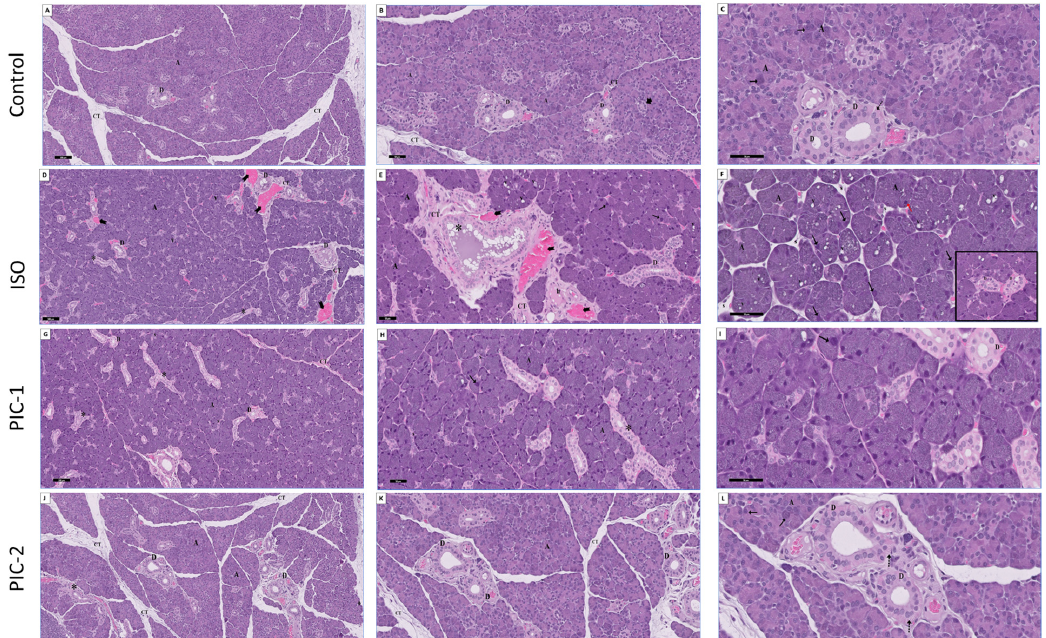
Figure 2. A section in the parotid gland stained with HE from the control group ( A – C ) showing the lobules of the gland, each lobule is formed of serous acini (A) and ducts (D) with wide connective tissue septa filled with a fine network of interlobular connective tissue fibers (CT) serous acini (A) consists of a single layer of pyramidal cells ( ↑ ) with basal rounded nuclei surrounding a lumen. Among the acini, intercalated ducts lined by cuboidal cells with rounded nuclei (arrowhead) and striated ducts (D) are observed and lined by a single layer of columnar epithelium (dot arrow) (HE; A × 100, B × 200, C × 400). ISO group ( D – F ) showing markedly hypertrophic packed secretory serous acini (A). Some of the acini exhibited irregular outline and spaces (s) appear between acini. The cytoplasm and basal lines of acinar cells are blurred, and the vacuolization (V) of acinar cells is obvious. Nuclei of serous acini appear enlarged and irregular in shapes and size with clumped chromatin hyperchromatic ( ↑ ) or with pyknotic nuclei (red ↑ ). Striated duct (D) appears disorderly arranged epithelium lining with loss of basal striation. Execratory ducts (*) appear with loss of pseudo-stratification and stagnated secretion in the lumen. The duct was surrounded by dens fi- brous connective tissue (CT) with hyalinization area (h) and congested dilated blood vessels (bifid head). Inset hyper magnification of straited duct (D) (HE; D × 100, E × 200, F × 400; inset × 400). Low dose of PIC (PIC-1 group) ( G – I ) showing improvement in the histological structure. Some areas of serous acini (A) contain large hyperchromatic nuclei ( ↑ ). Apparently large lobules are separated by relatively thin connective tissue septa (s) with few collagens’ fibers deposition. Striated duct (D) with columnar cells and basal striation is detected. Some of the excretory ducts (*) shows loss of pseudo-stratification in some areas. (HE; G × 100, H × 200, I × 400; inset × 400). High dose of PIC (PIC-2 group) ( J – L ) showing marked improvement in the histological structure. The parotid gland appears nearly as the control group. Each lobule is formed of serous acini (A) and ducts (D) with wide connective tissue septa filled with a fine network of interlobular connective tissue fibers (CT) serous acini (A) consists of a single layer of pyramidal cells ( ↑ ) with basal rounded nuclei surround- ing a lumen. Among the acini, striated ducts (D) are observed and lined by a single layer of colum- nar epithelium (dot arrow). (HE; J × 100, K × 200, L × 400; inset ×400). Some of the acini showed deeply basophilic stained pyknotic nuclei. Aside from that, cells in the gland ducts were distributed in an unorganized fashion with the lack of basal striation in the striated duct, which had smaller secretory granules. In addition, the excre- tory ducts showed loss of pseudo-stratification with flattening of the cells and stagnated secretion in the lumen. The duct was surrounded by dense fibrous connective tissue with a hyalinization area and congested dilated blood vessels. In the current study, the parotid gland of a low dose of PIC (PIC-1 group) revealed an improvement in the histological